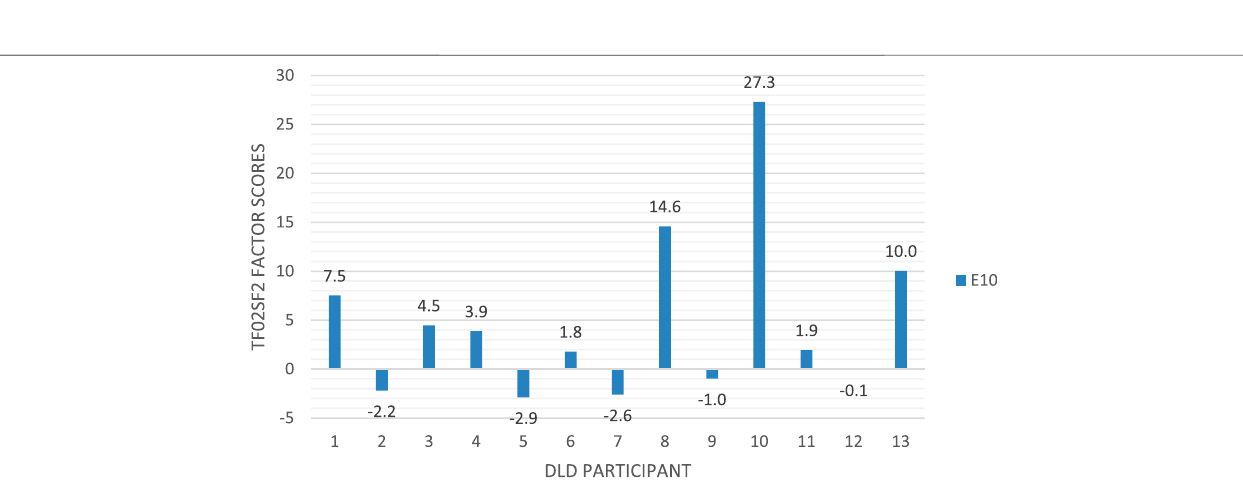
Frontiers in Communication |